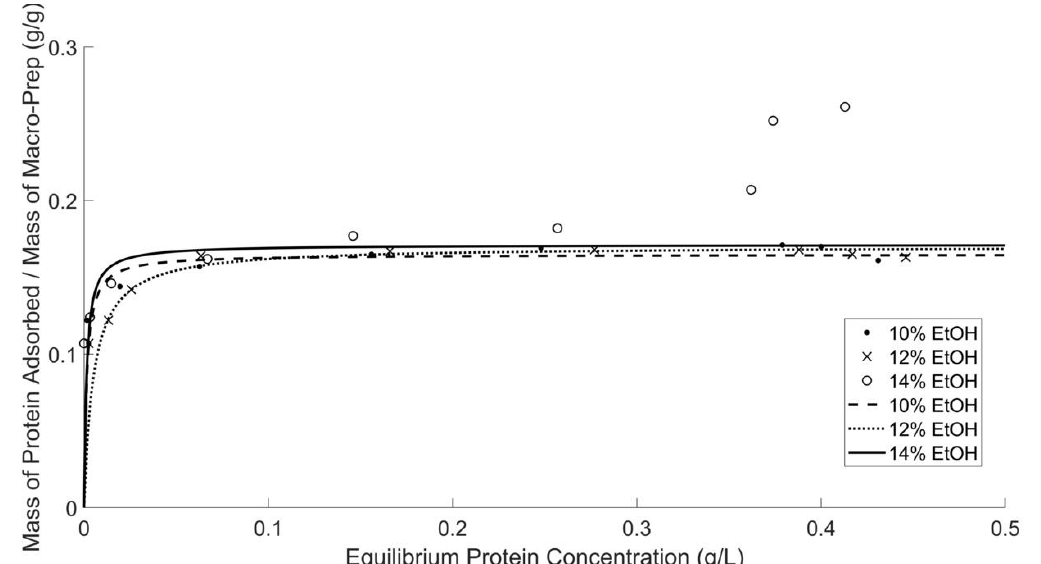
Figure 3. Macro-Prep ® ’s protein adsorption ability in model wine solutions with different ethanol concentrations by using the Bradford protein assay and UV-Vis spectrometer at 595 nm. Data for 14% v/v ethanol fitted only up to 0.3 (g BSA)/L.